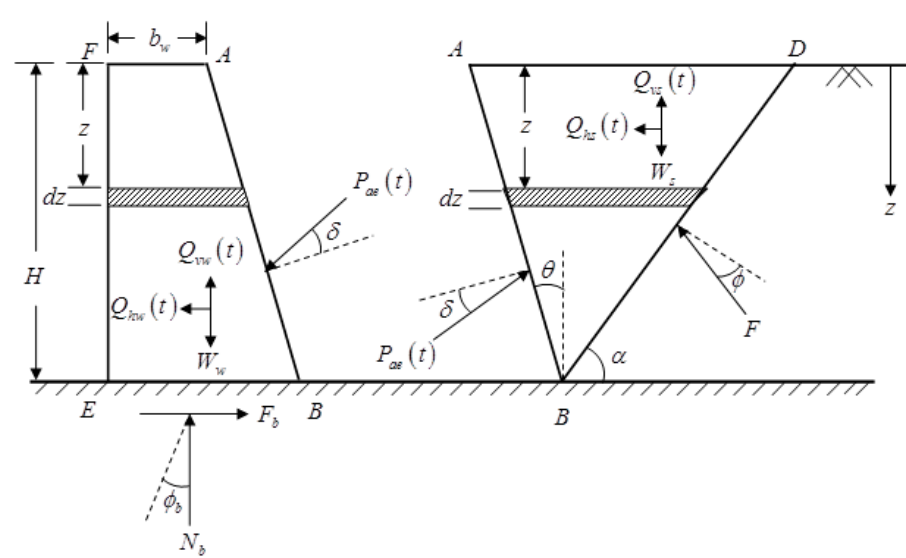
Figure 1. Details of forces acting on the soil wedge and the wall.